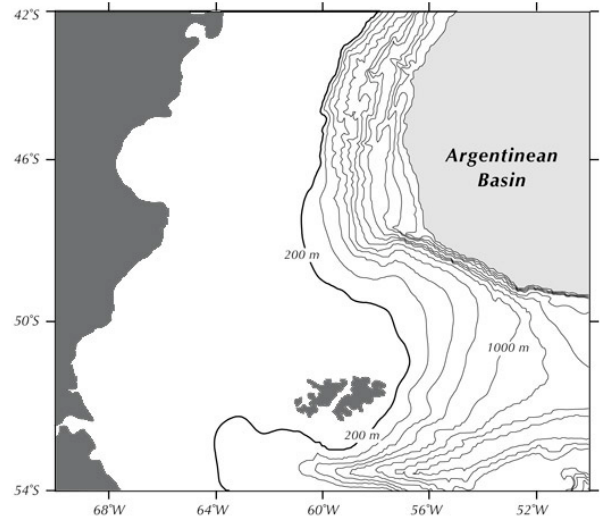
Fig. 15. Bottom topography of the Patagonian shelf. Note the rapid convergence of the isobaths north of ∼ 50 ◦